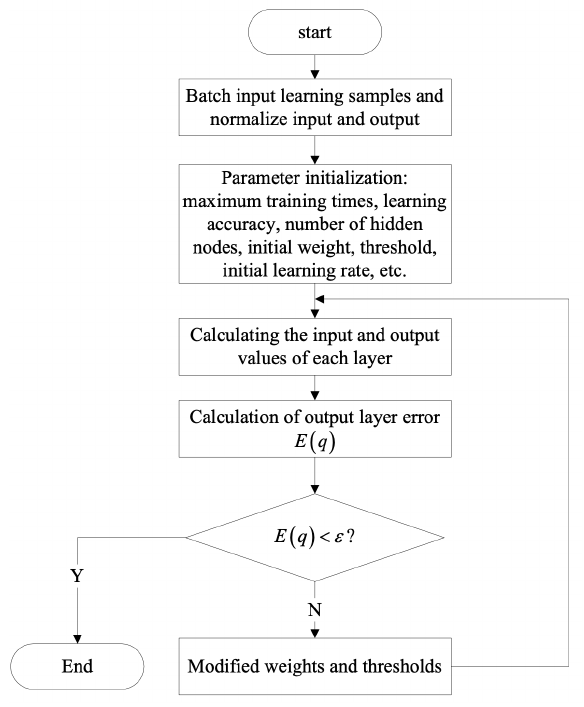
Fig. 1. PROGRAM FLOW CHART OF BP